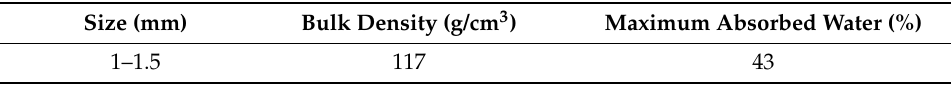
Table 3. Properties of porous sand given by the supplier.